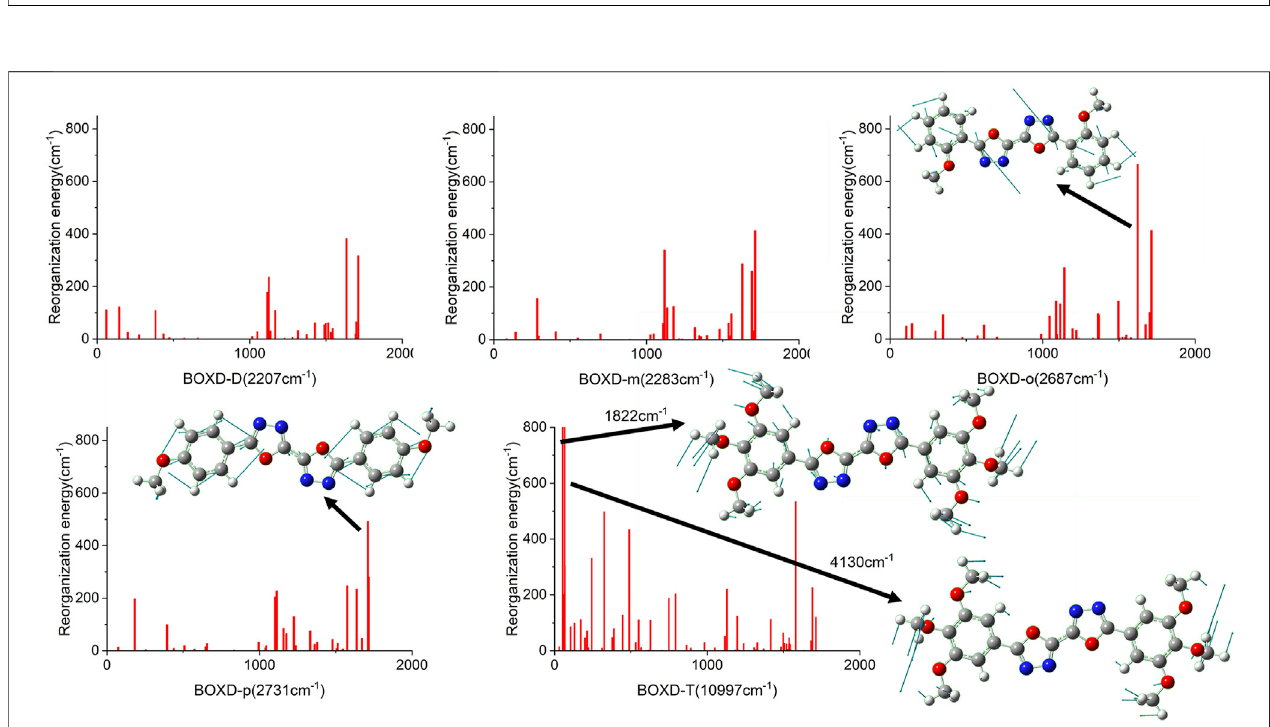
FIGURE 8 | Calculated reorganization energies versus the normal-mode frequencies and the normal mode displacement vectors for the largest reorganization energy of fi ve molecular structures.